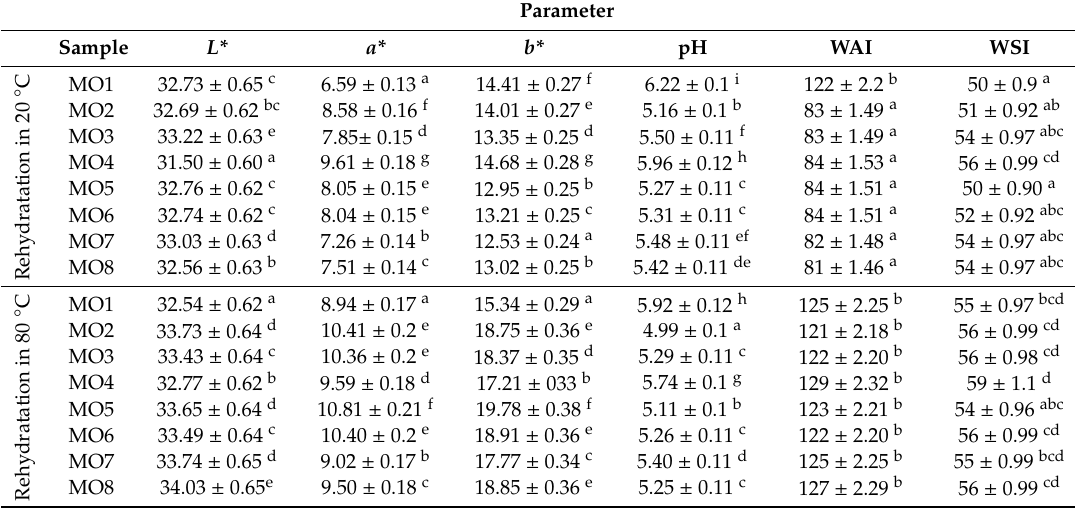
Table 2. Di ff erences in physical properties after di ff erent rehydration temperatures